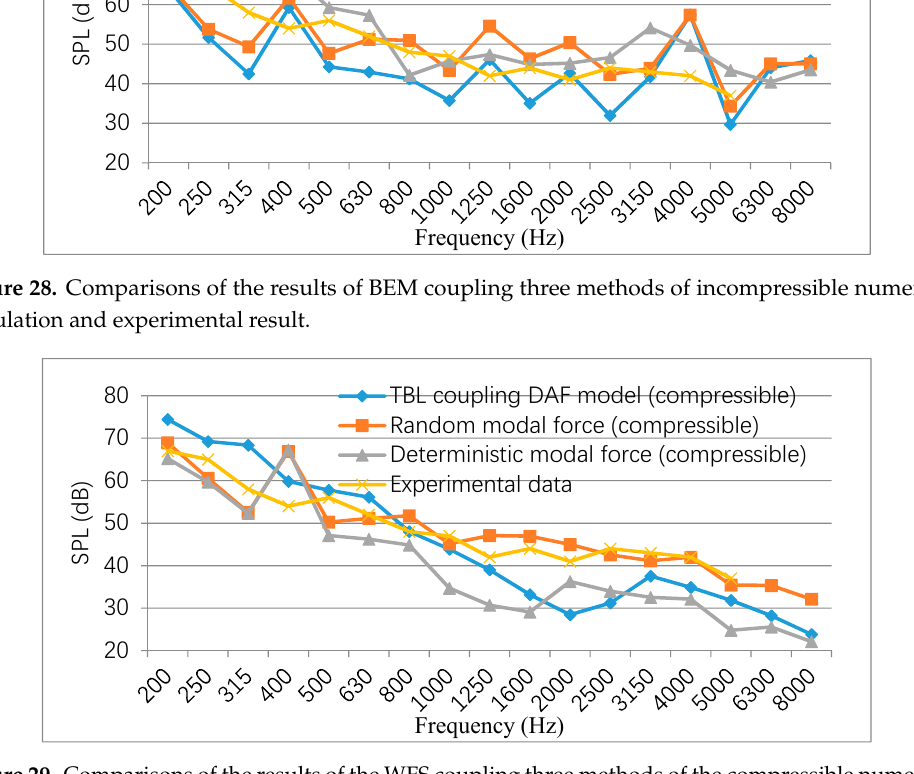
Figure 29. Comparisons of the results of the WFS coupling three methods of the compressible numerical simulation and experimental result.